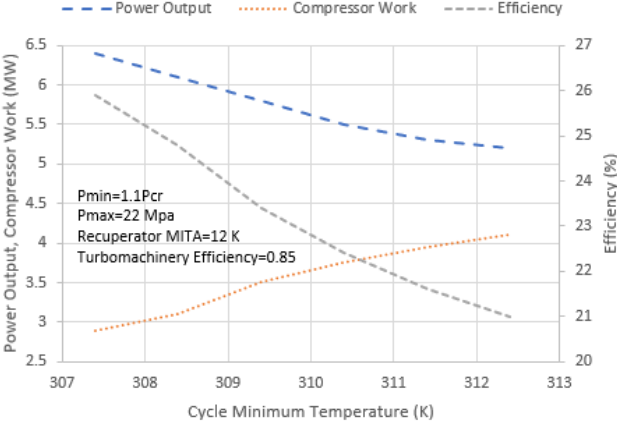
Figure1. PerformancedecrementofS-CO 2 Figure 1. Performance decrement of S-CO 2 Brayton power cycles at higher cycle minimum temperatures.